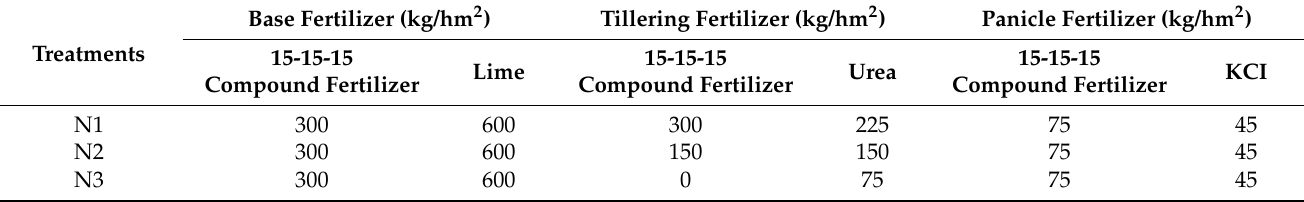
Figure 1. Overview of the study area. ( A ) geographical location of the study area and ( B ) fertilizer conditions in each plot. N1, N2 and N3 represent the different tillering fertilizer treatment (N1: 300 kg/hm 2 15-15-15 compound fertilizer and 225 kg/hm 2 urea; N2: 150 kg/hm 2 15-15-15 compound fertilizer and 150 kg/hm 2 urea; N3: 75 kg/hm 2 urea.) Table 1. Basic information of fertilizer treatment in the study